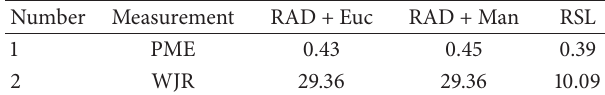
Table 5: Performance for path A under pattern b (109s).